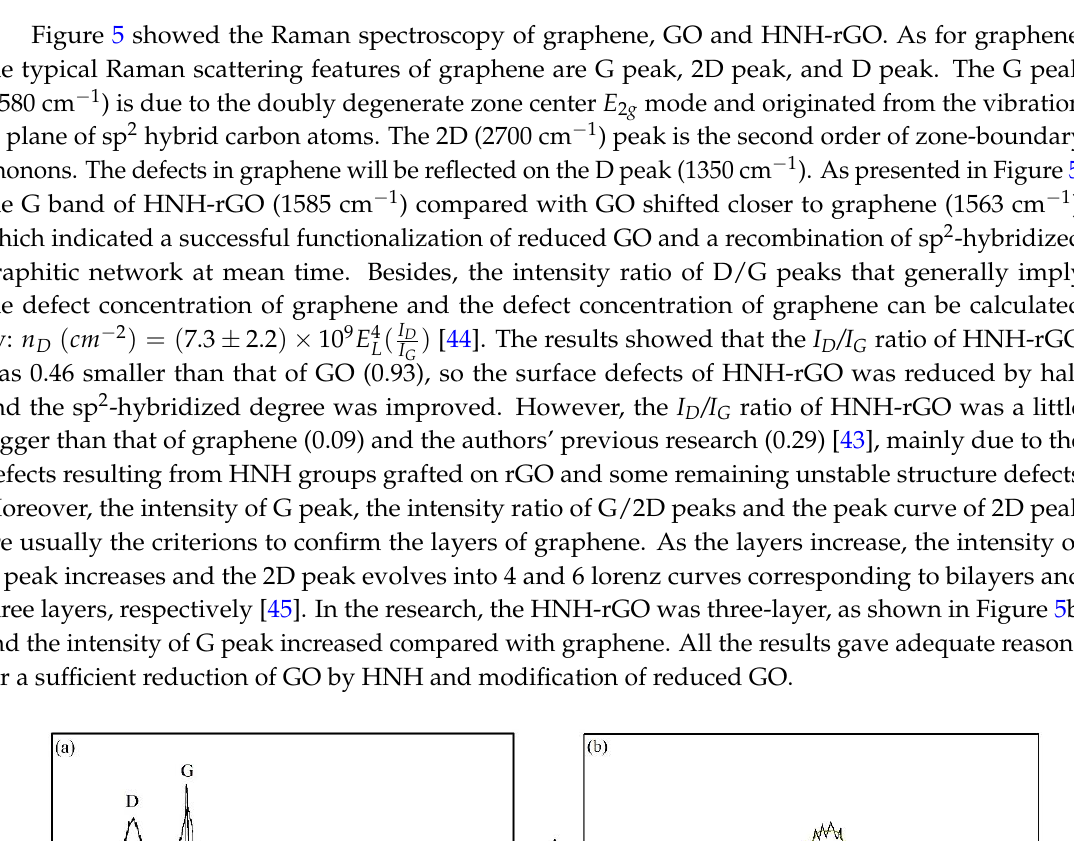
Figure 4. The scanning electron microscope (SEM) images of GO ( a ) and HNH-rGO ( b ).